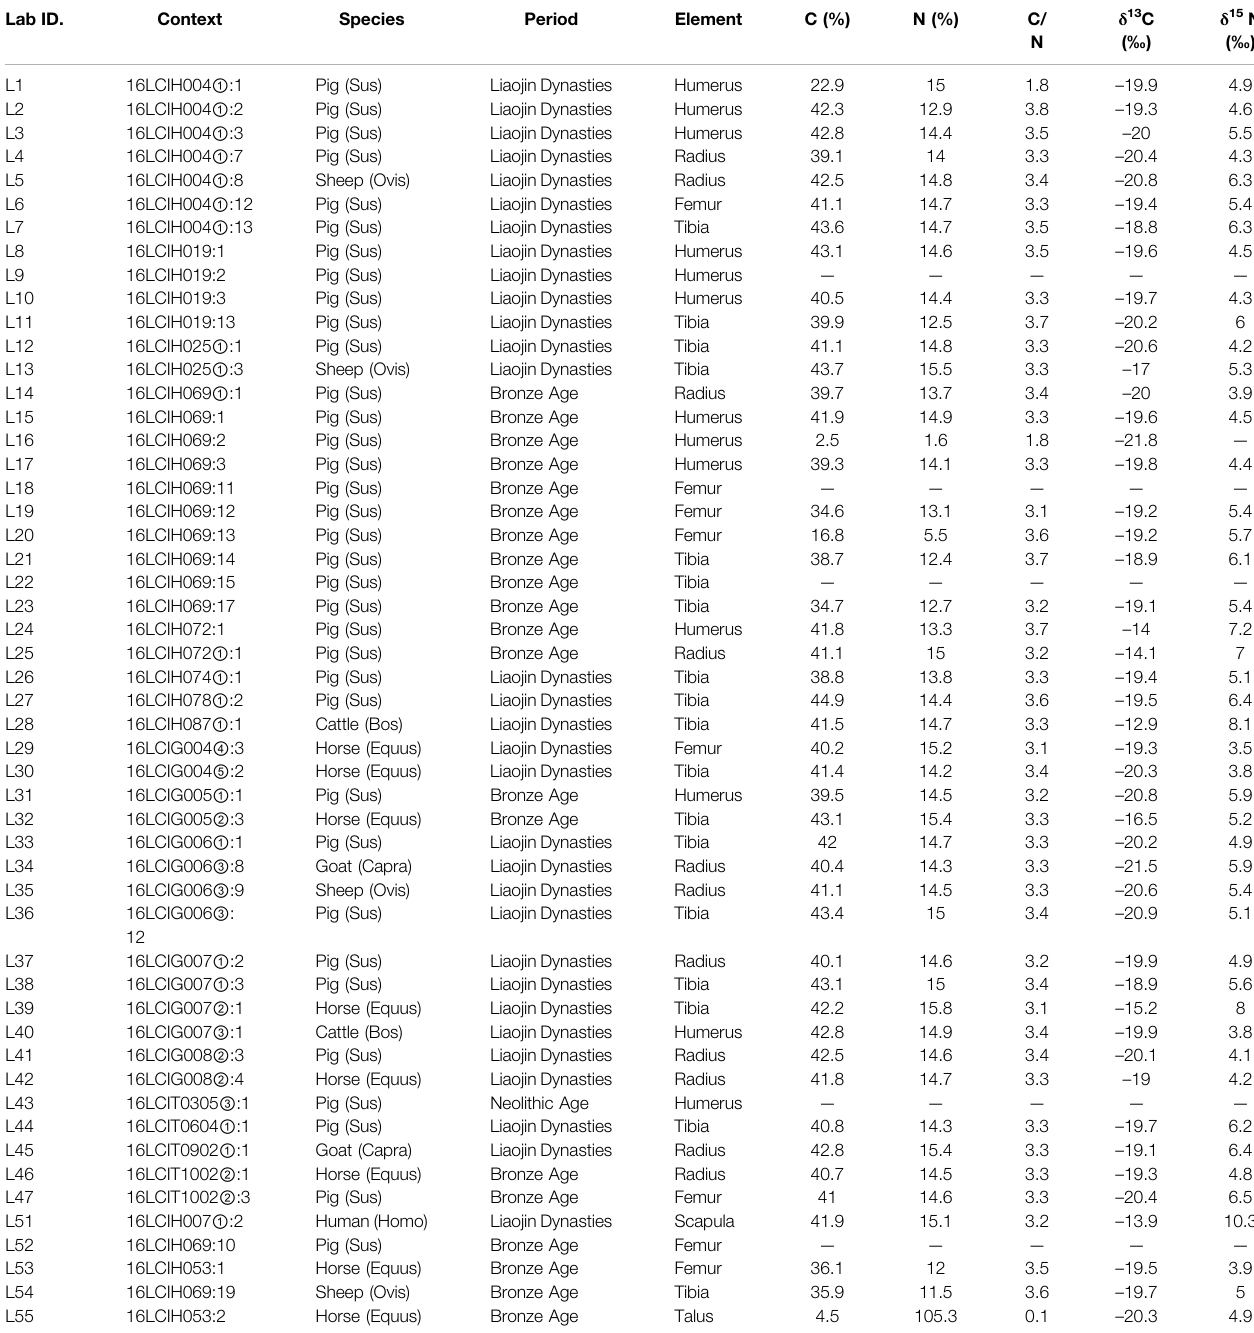
TABLE 1 | Isotopic results and sample information for fauna from the Changshan site. Lab